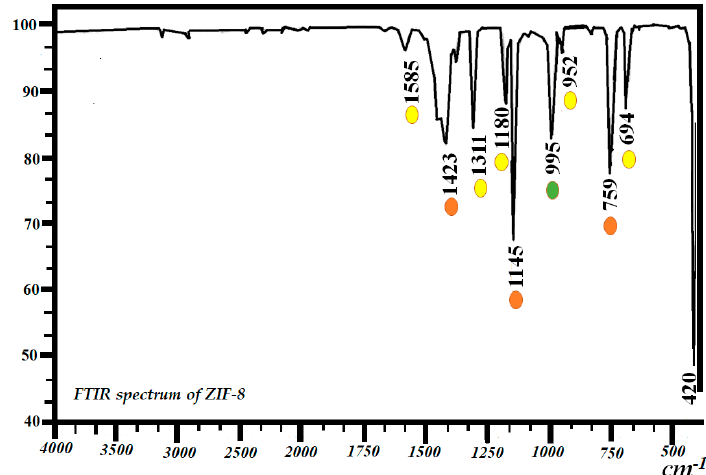
Figure 3. FTIR spectrum of ZIF-8.